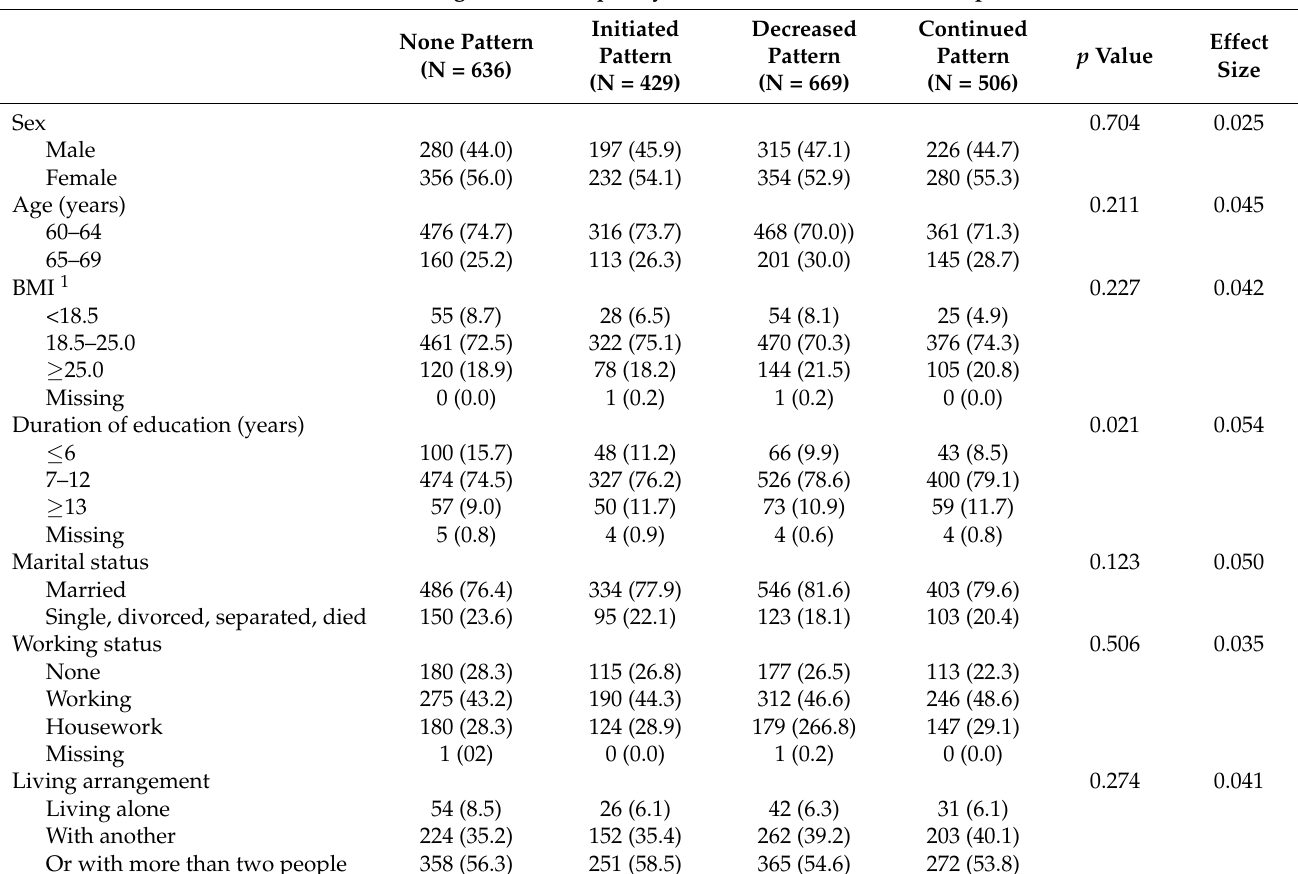
Table 2. Background characteristics of the study participants by changes in the frequency of the pattern of social